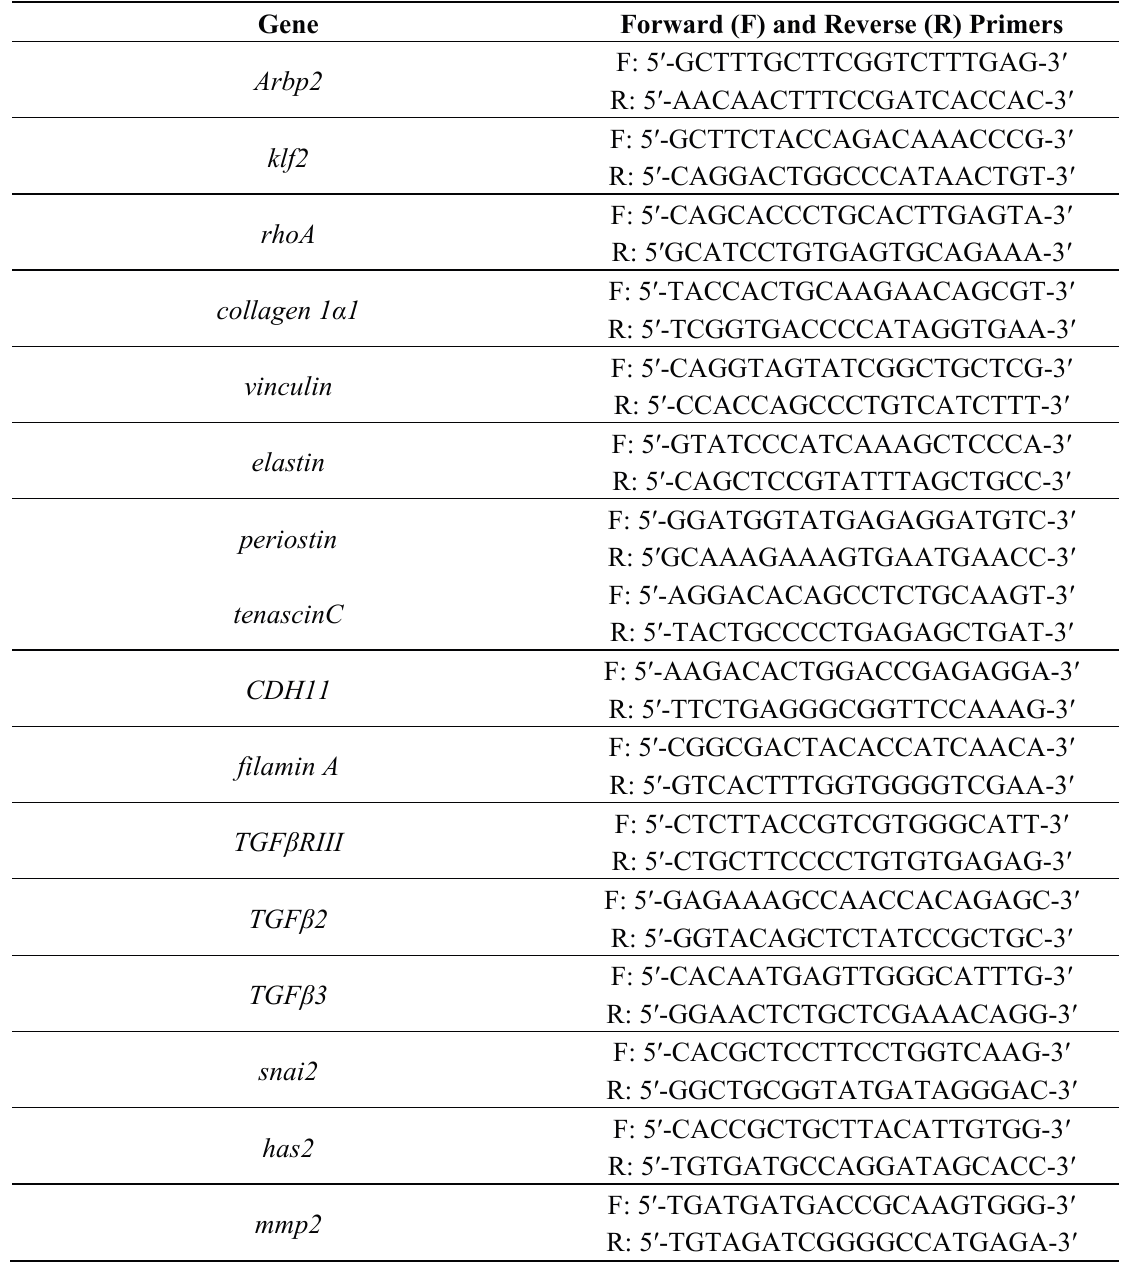
Table 1. Primers used for